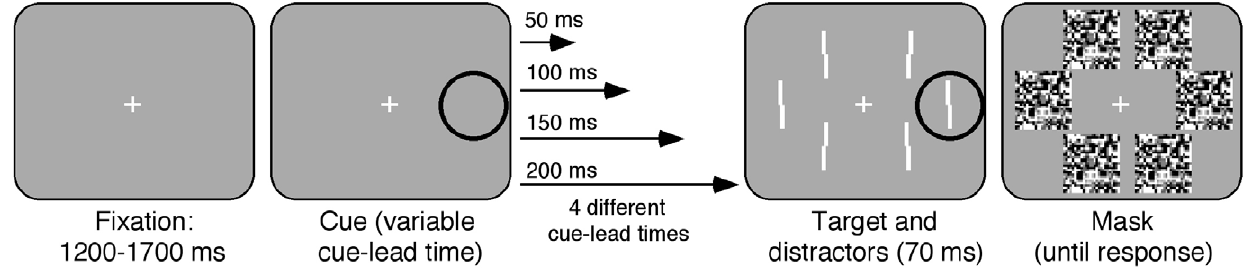
Figure 1. The sequence of events on a single experimental trial in experiment 1. A fixation point was presented for 1200 to 1700 ms (determined randomly for each trial) followed by the cue presented for 50, 100, 150 or 200 ms (see methods section for details upon the probability of a given CLT). Following the presentation of the cue, the Vernier acuity stimuli were presented for 70 ms followed by the local random dot masks, which were present on the screen until response.